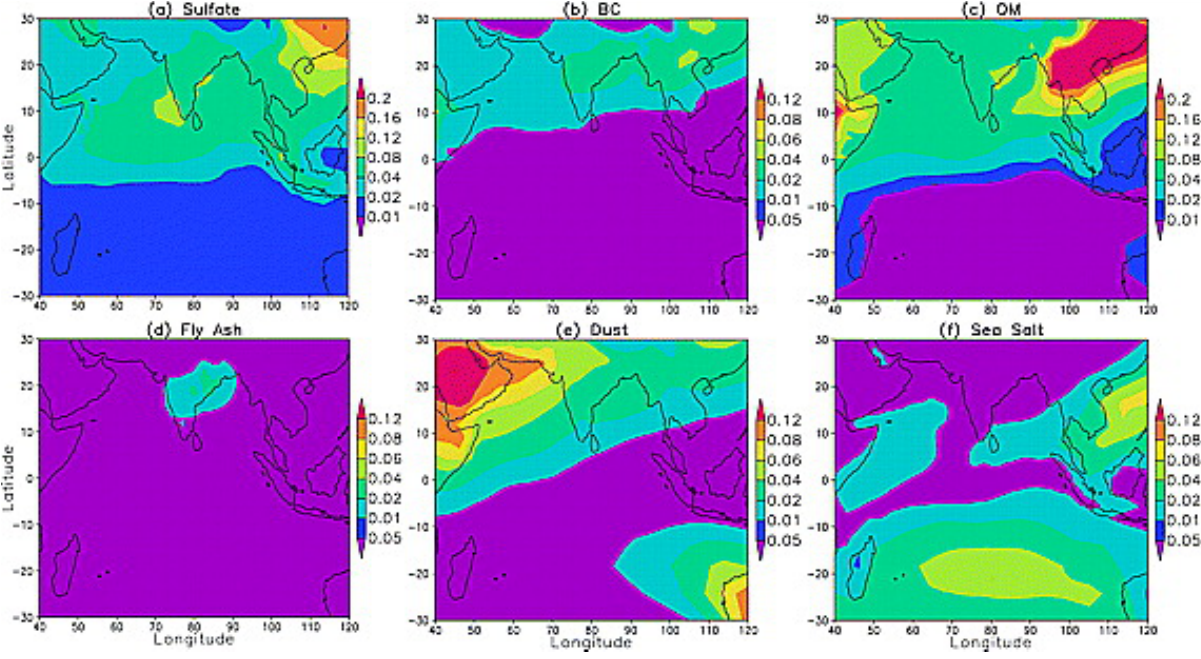
Fig. 26. AOD at 550nm from different aerosol species: (a) sulfate, (b) black carbon (BC), (c) organic matter (OM), (d) fly ash, (e) dust, and (f) sea salt (from Reddy et al., 2004, copyright 2004 by the American Geophysical Union, reproduced with